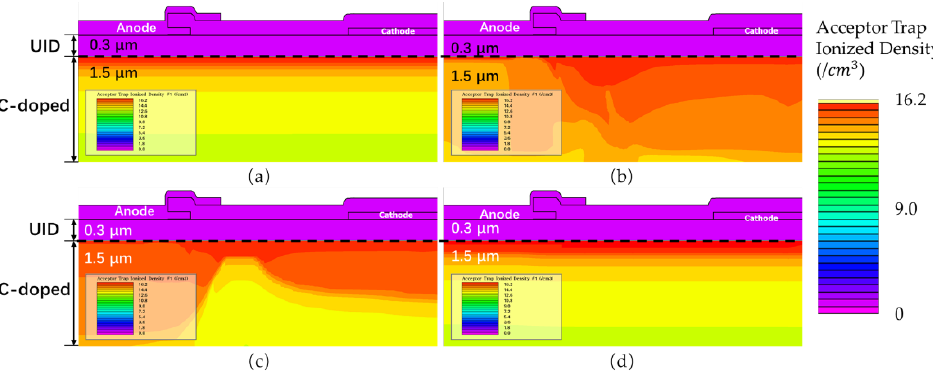
Figure 10. The acceptor trap ionized at different times. ( a ) t 0 : the initial state; ( b ) t 1 ; ( c ) t 2 ; and ( d ) t 3 .